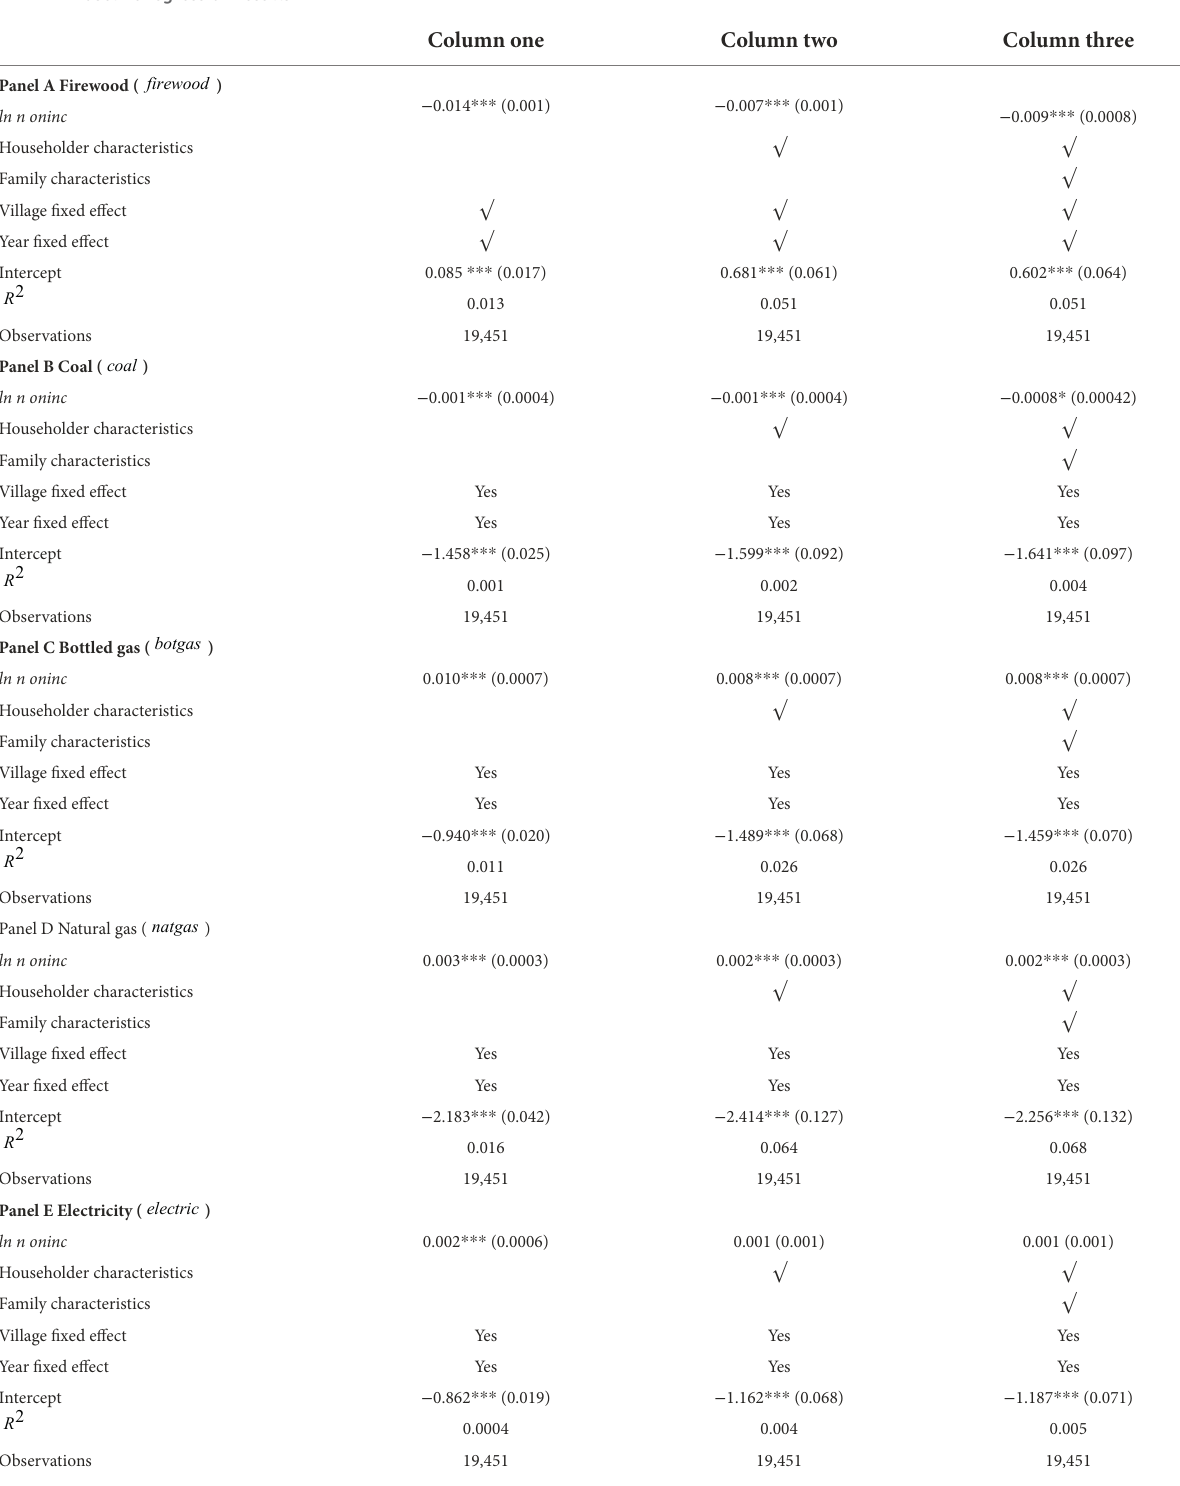
TABLE 2 Baseline regression results. Column one Column two Column